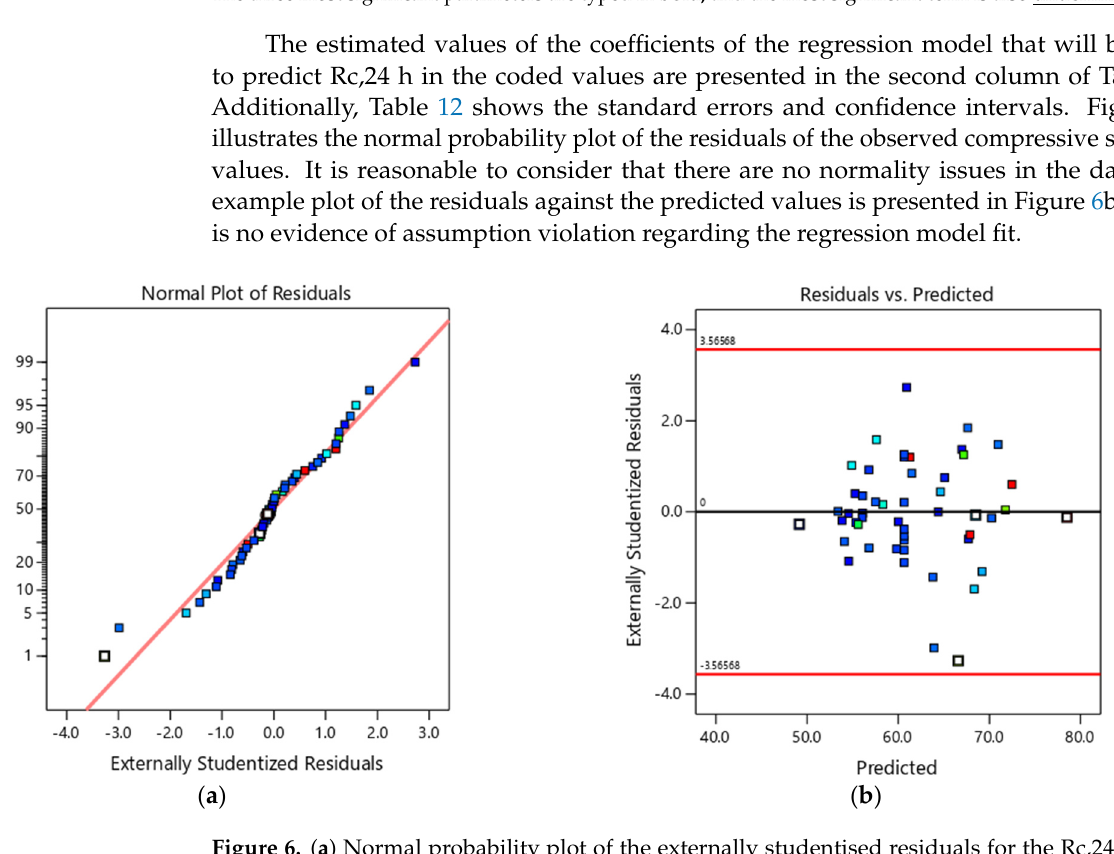
than 1.0 or high leverage were not found (see Figure Table 12. Rc,24 h model coefficients in terms of coded values.